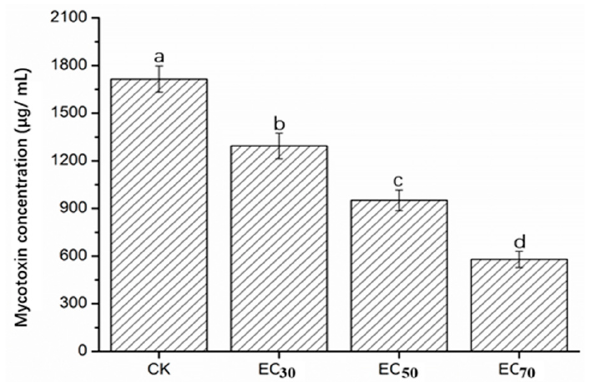
Figure 4. Mycotoxin production (mainly fusaric acid) concentration in FON with cuminic acid treatments at concentrations of EC 30 (5.6 μ g/mL), EC 50 (22.53 μ g/mL) and EC 70 (91.3 μ g/mL) in liquid culture. Bars denote the stand error of three experiments. Data represents means of three replicates with standard deviation. Data (means ± SD, n = 3) followed by the same letters in the row show no significant differences (small letters, p < 0.05).